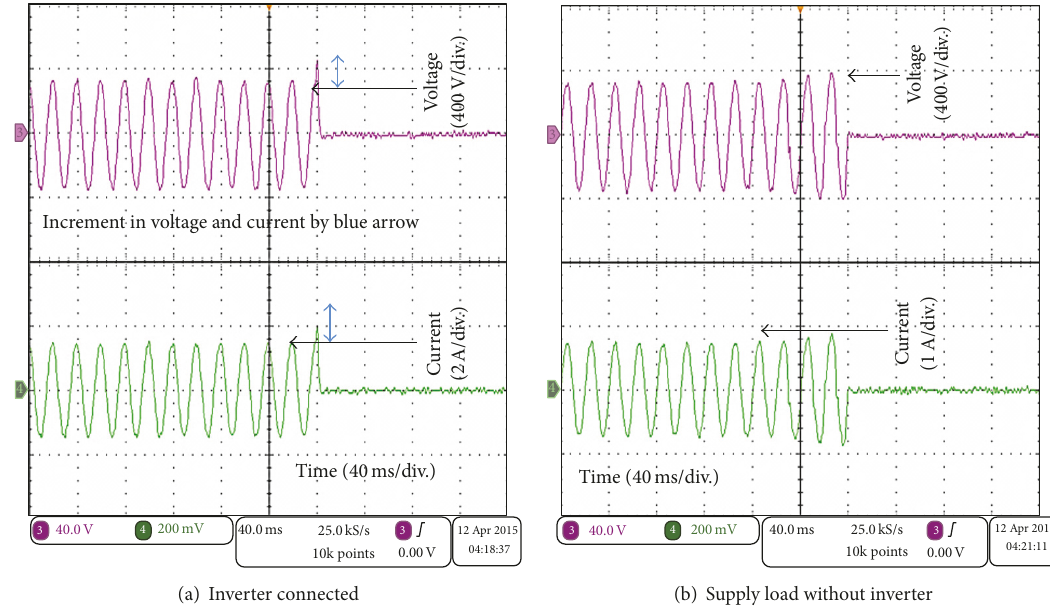
Figure 14: Waveforms of the load voltage in pink colour [10V/Div.] and the current in green colour [10A/Div.].